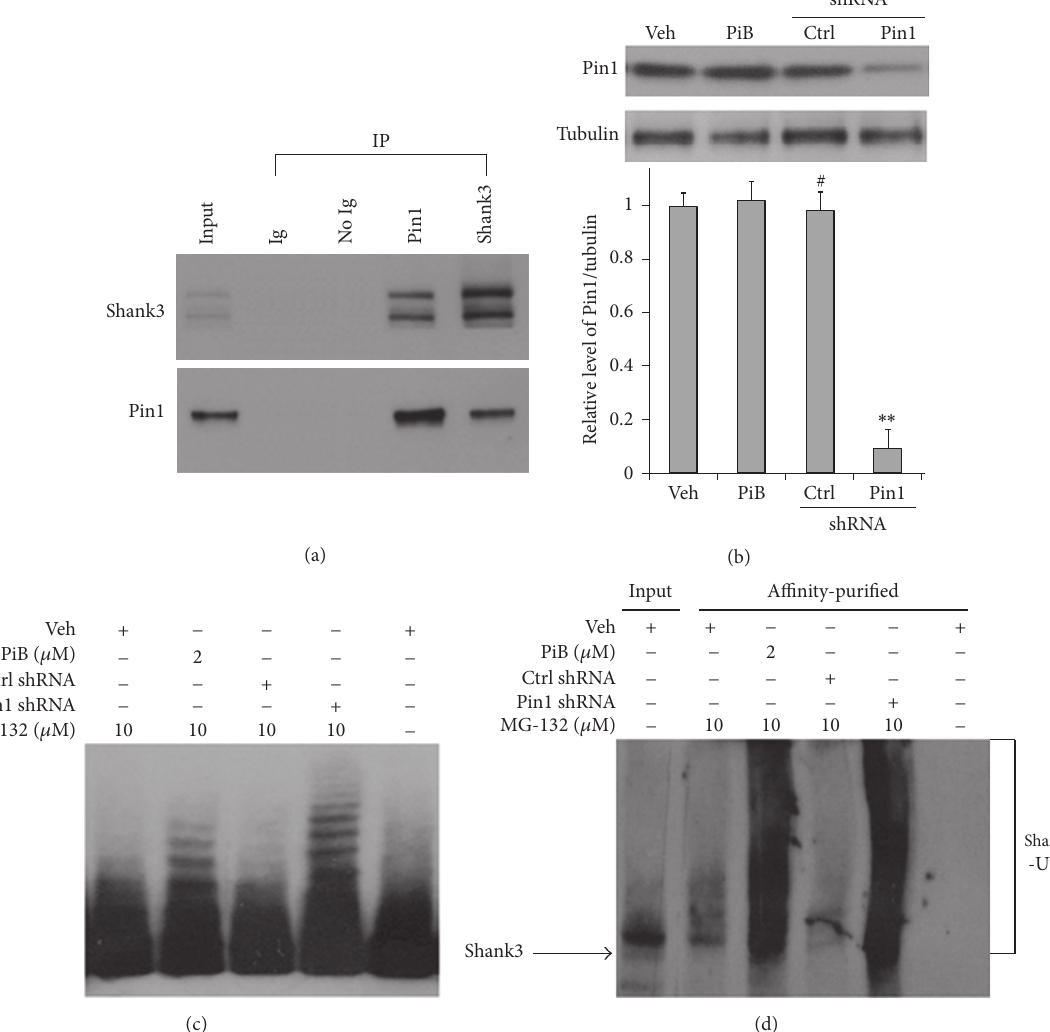
Figure4:BlockingofPin1activityincreasesthemodificationofubiquitininPSDproteins.C57/BL6corticalneuronsat21DIVwereincubated with PiB and MG-132 for 24 h and transfected by Pin1 shRNA or control shRNA lentivirus for 48 h, respectively; the PSDs were isolated and analyzed with Western blot. (a) Coimmunoprecipitation between Pin1 and Shank3 proteins. (b) Total Pin1 proteins were knocked down ( 𝑛 = 7 dishes for each experimental condition, ∗∗ 𝑝 < 0.01 ; # 𝑝 > 0.05 ). (c) Ladders of Shank3 proteins after the loss of Pin1 activity. (d) Ubiquitinated Shank3 proteins were enriched by ubiquitin-affinity purification and recognized by Shank3 antibody in Western